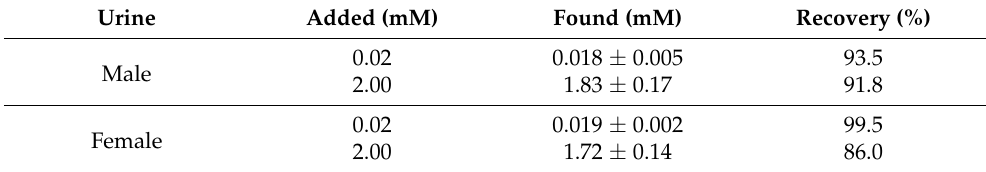
Table 3. Determination of adenosine triphosphate (ATP) in spiked urine samples.